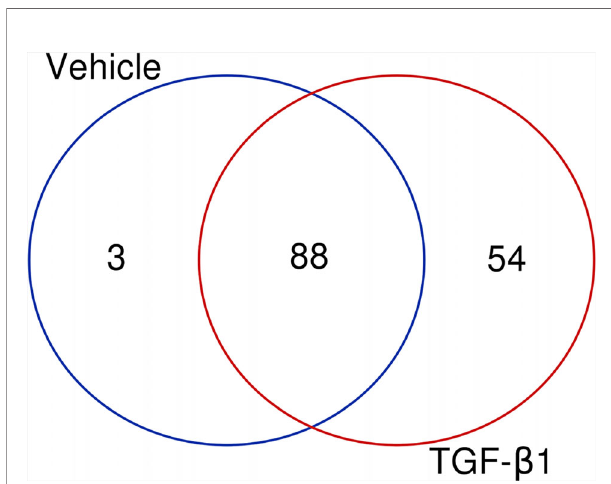
FIGURE 4 | LMTK2 KD affects the expression of 88 genes in both vehicle- or TGF- b 1-treated CFBE41o- cells. CFBE41o- cells transfected with siLMTK2 or siCTRL were treated with vehicle control or TGF- b 1 for 24h. Total RNA was isolated using Quick-RNATM MiniPrep kit (Zymo Research) and quanti fi ed on Illumina NextSeq 500 ’ s (Illumina). An overlap of 88 genes affected by LMTK2 KD was observed in cells treated with TGF- b 1 or vehicle control. Vehicle treatment distinctly affected the expression of 3 genes, while TGF- b 1 treatment compromised the regulation of 54 distinct genes. Venn diagram was obtained in http://bioinformatics.psb.ugent.be/webtools/Venn/.